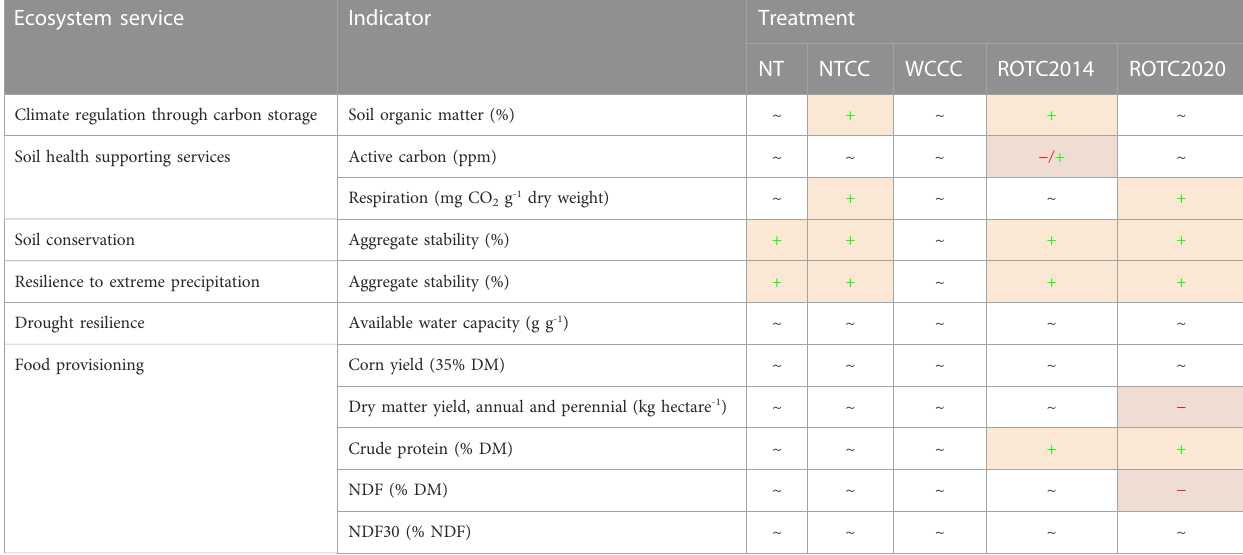
TABLE 4 Signi fi cant in fl uences on ecosystem service provisioning by treatment compared to continuous corn (CC). This is based on the repeated measure mixed model that incorporates that in fl uences of treatments, time and time:treatment interactions from 2012 to 2021. The “ − ” symbol is a negative impact, the “ + ” symbol is a positive impact, the “ ~ ” symbol indicates is is not signi fi cant, and “ − /+ ” indicates a variable impact depending on year. Ecosystem